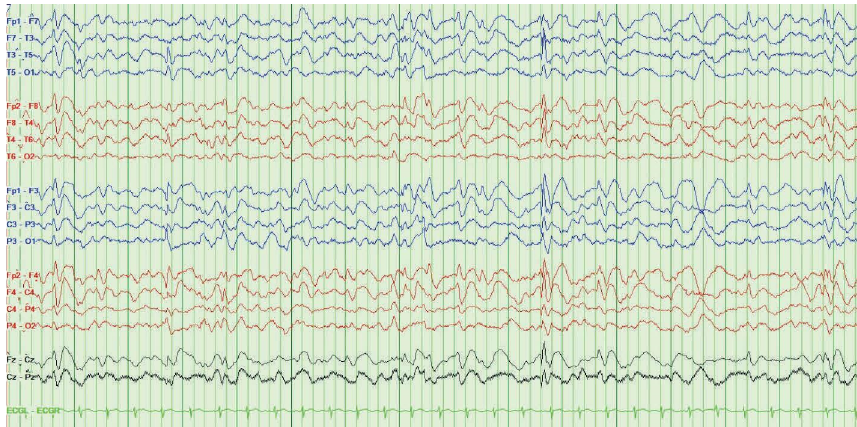
Figure 1: Interictal EEG shows difuse slowing along with bursts of generalized spike and slow wave